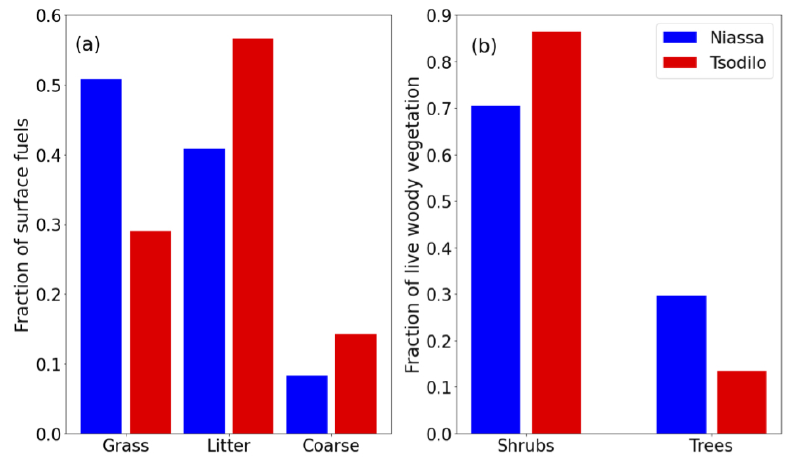
Figure 9. Mean proportion of ground measurements represented by ( a ) each surface fuel class to total surface fuels (the sum of grass+litter+coarse) and ( b ) live woody fuel classes (i.e., live trees or shrubs) to total live woody vegetation (the sum of trees+shrubs) for the two study regions.